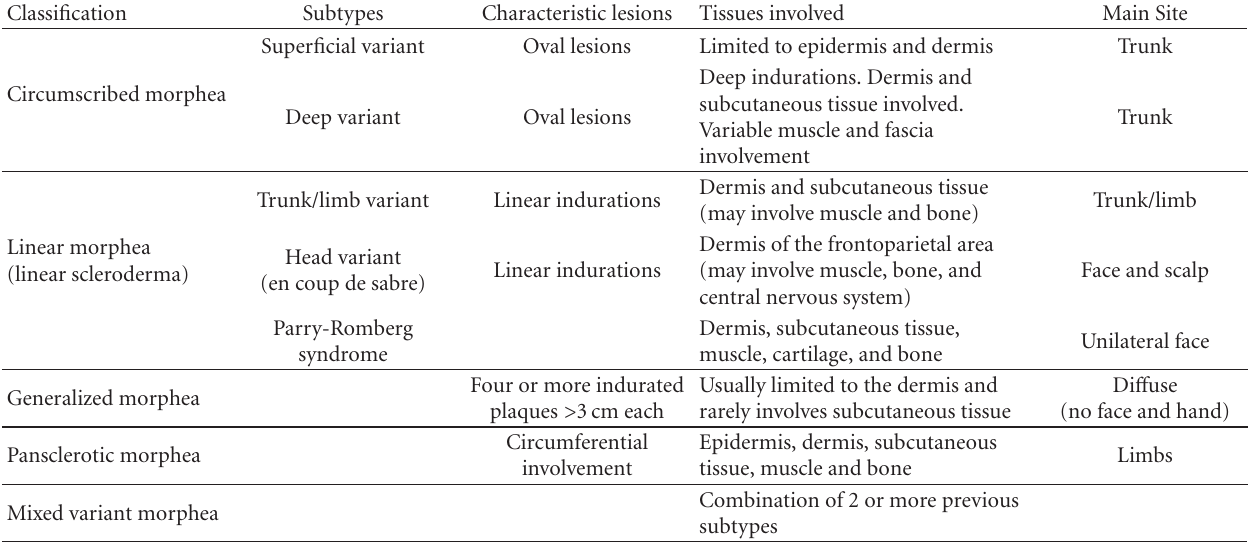
Table 1: Localized scleroderma